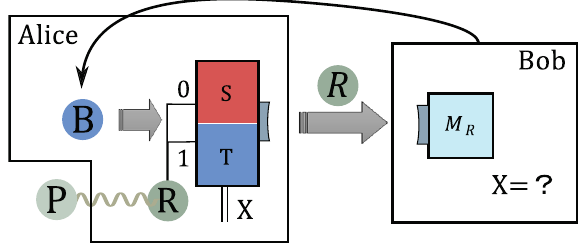
Fig. 1 Guessing game. In the d -dimensional guessing game, Bob prepares a quantum state ρ B of dimension d and sends it to Alice. Then Alice performs the measurement S or T on the system ρ B according to the two-dimensional register state ρ R through a quantum control as shown in Fig. 2. After Alice completes the measurement, Bob tries to guess Alice ’ s measurement outcome X = x by measuring the register state ρ x . In this process, R can be R entangled with a system P , which remains inaccessible to Bob. Since some information about Alice ’ s measurement process can be contained in that register P , in that case Bob cannot obtain full quantum information about Alice ’ s